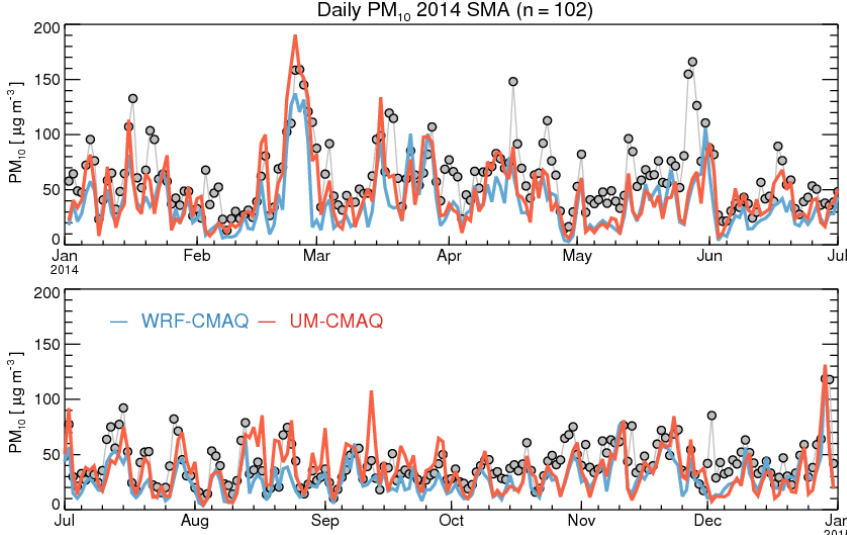
Figure 4. Time series of daily averaged PM 10 over SMA surface monitoring sites during 2014.